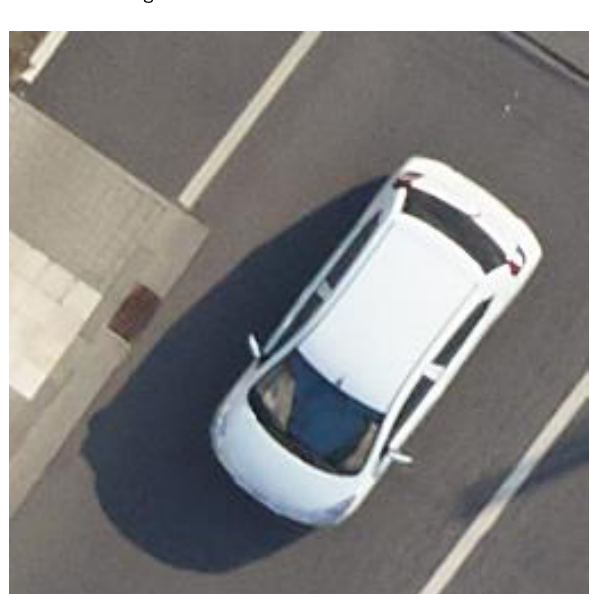
Figure 8. Detail of iXU-R 1000 without FMC